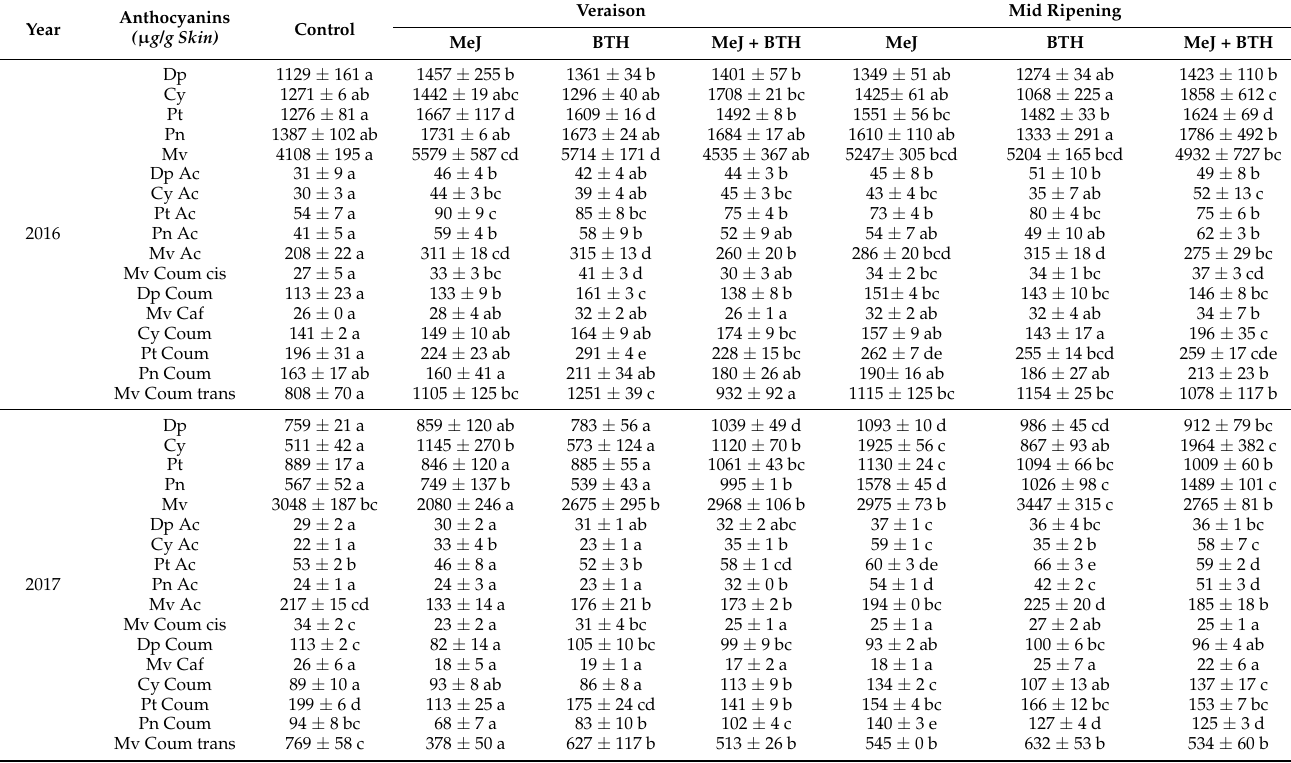
Table 2. Concentration of anthocyanins measured by HPLC in the skin of Monastrell grapes treated with MeJ, BTH, and MeJ + BTH at two different application times: veraison and